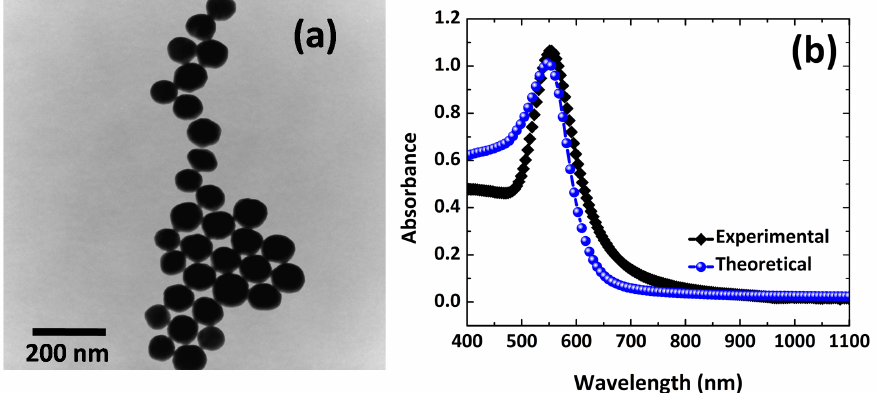
Figure 4. ( a ) TEM image of Au NPs and scale is 200 nm. ( b ) Optical absorbance of Au NPs in colloid and comparison numerical study using FEM computational modeling and experimental analysis.